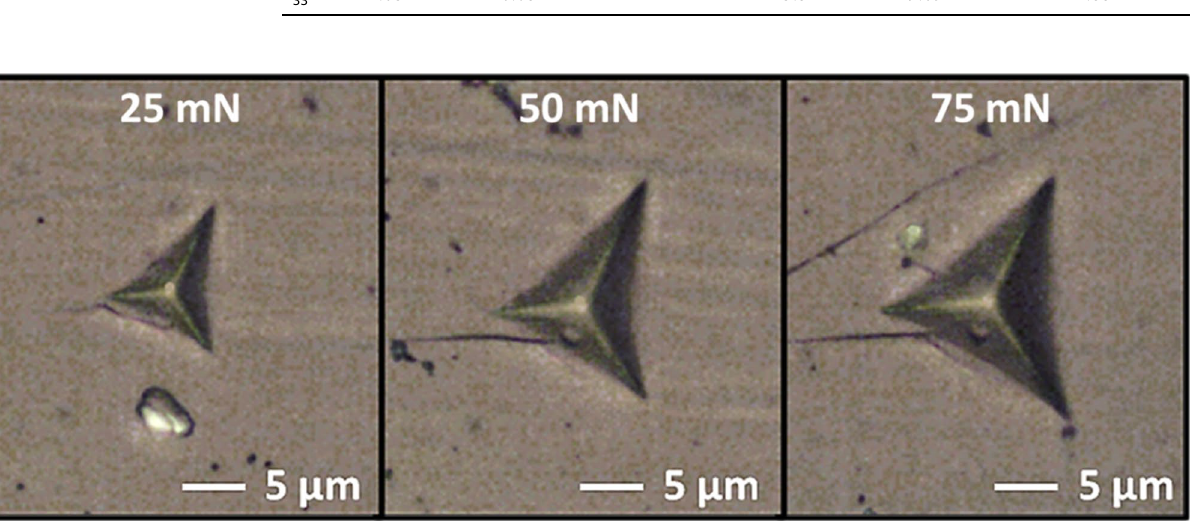
Fig. 7 Imaged indentations performed on the (010) facet of a β-HMX